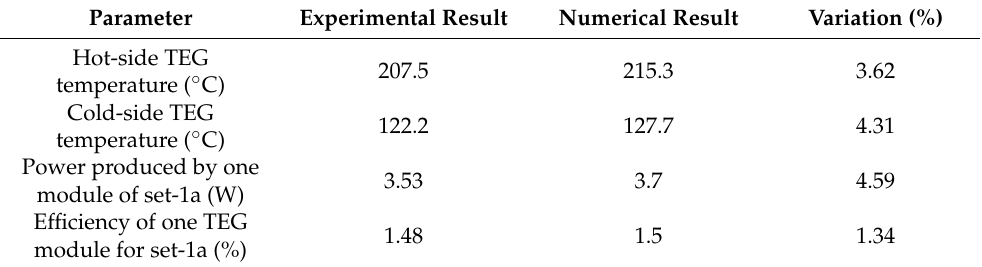
Table 4. Comparison of experimental and numerical results.